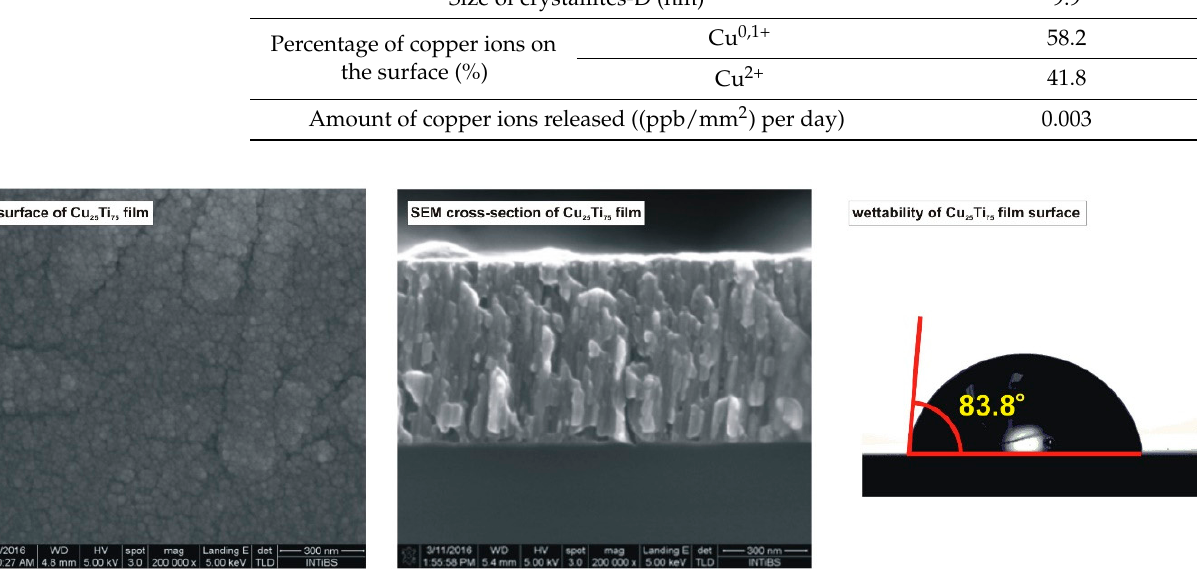
Figure 1 . SEM (scanning electron microscopy) images of the surface and cross-section of Cu 25 Ti 75 thin film with the result of wettability measurements—a view of a water drop on the film surface .